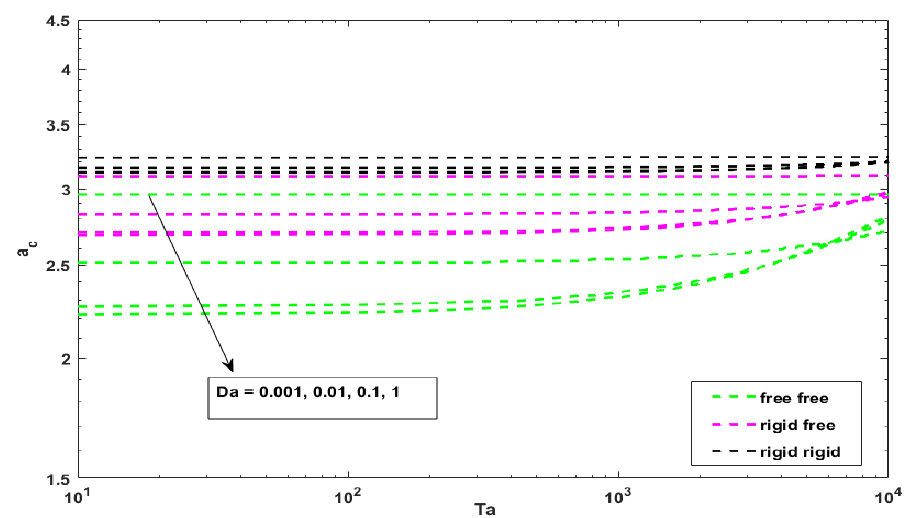
Figure 10. Variation of Ra c with Ta for Sr = 0.2, Du = 0.02, Rs = 200, Le = 5, Λ = 8, M = 0.9 , ϕ = 0.9.